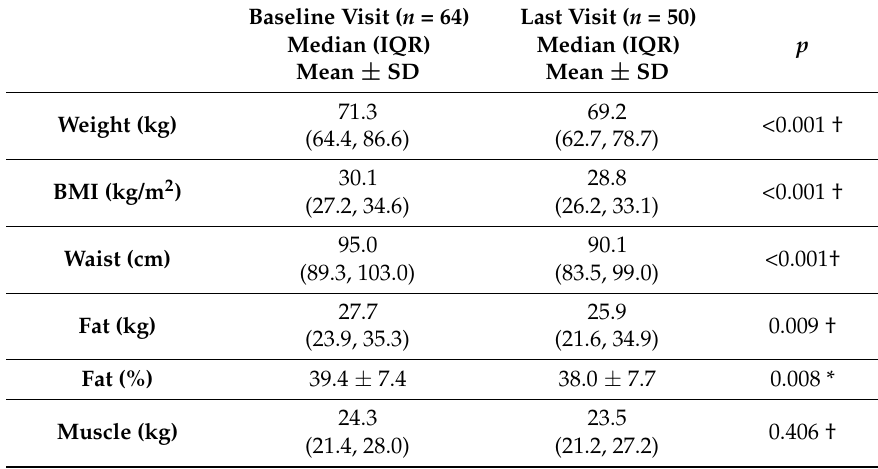
Table 3. Anthropometric data of parents in baseline and last visits.